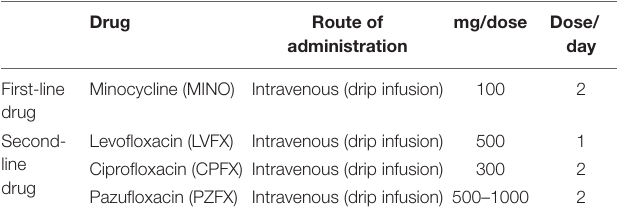
The table is adapted from the guiding principle of JSM (http://square.umin.ac.jp/ jsm/shisin.pdf).